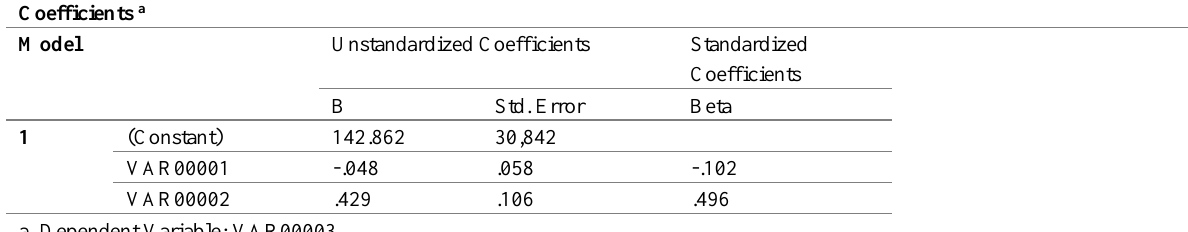
Table 9: Results of Multiple Linear Regression